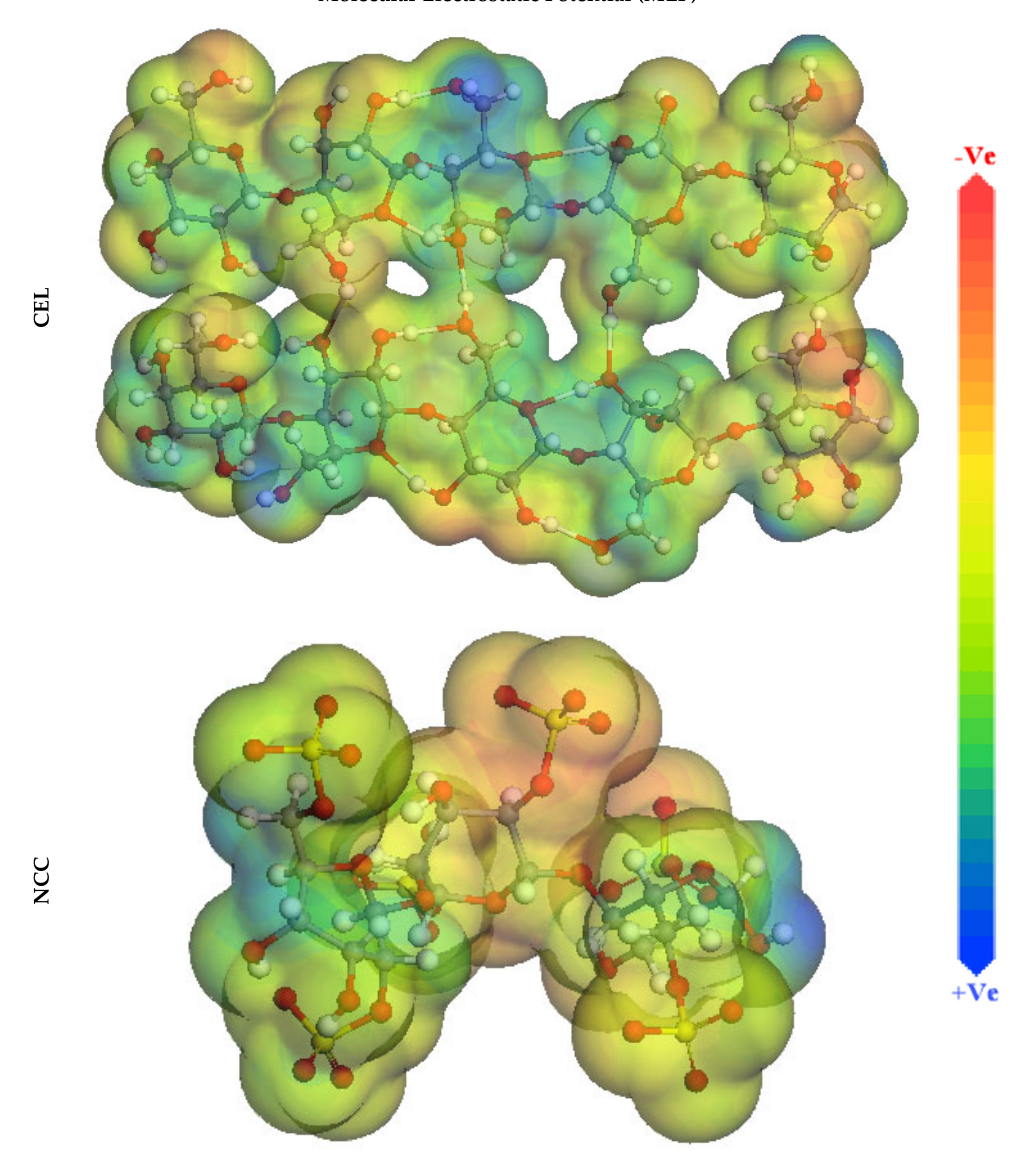
Figure 14. Graphical presentation of the MEP of the CEL and NCC using DMol3 module.